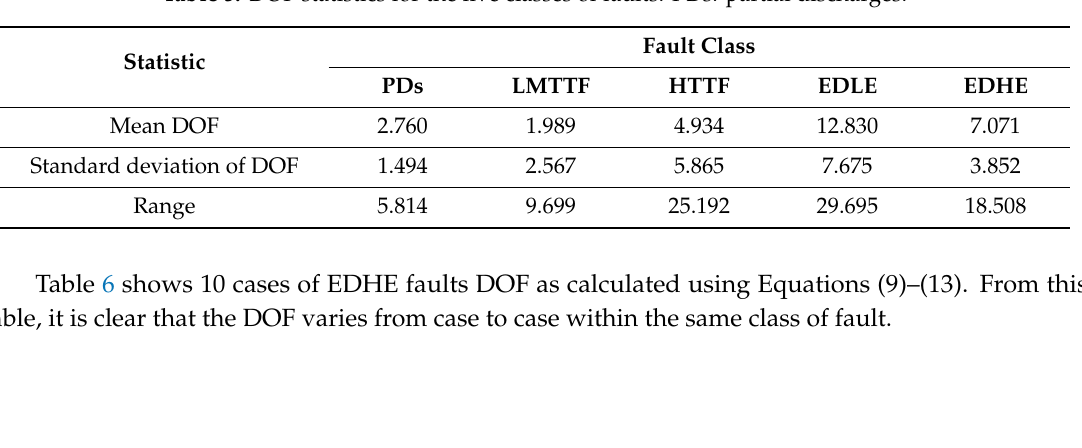
Figure 11. DOF for various equipment per fault type. Table 5. DOF statistics for the five classes of faults. PDs: partial